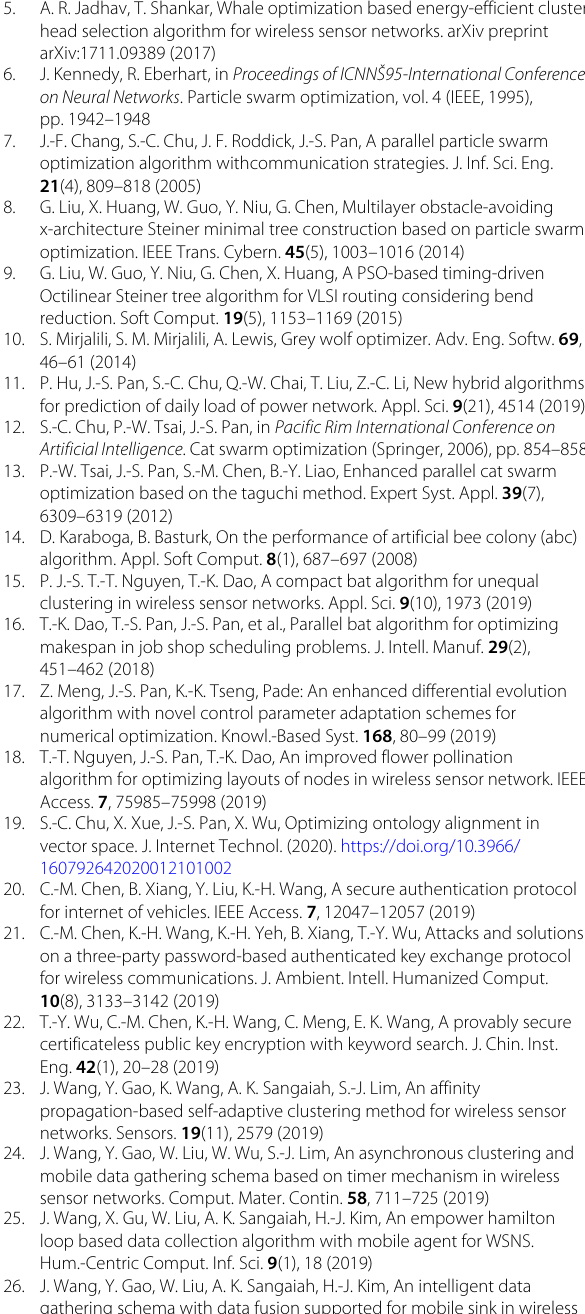
Table 5 The localization error of varying node density shows the experimental results of varying node density Node number DV-Hop PSO WOA Variable Mean Std Mean Std Mean Std Mean Std Mean Std 100 0.3432 0.0000 0.3941 0.0113